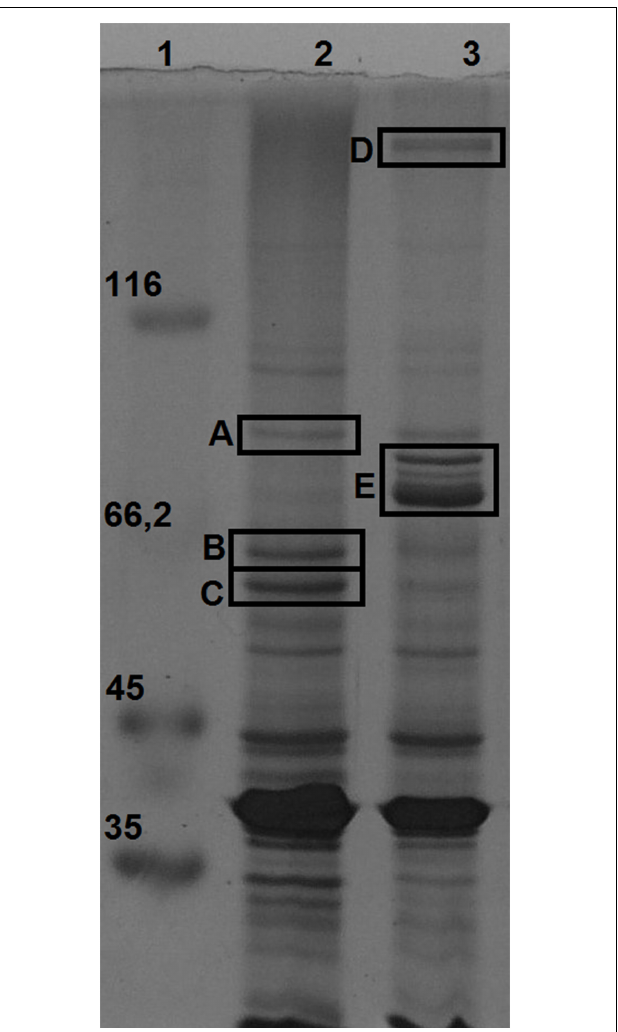
FIGURE 3 | Membrane proteins regulated by iron availability at late exponential growth phase. SDS-PAGE 12% acrylamide gel of total membrane protein enriched fractions of bacteria grown in NFbHP-malate media with different iron conditions: 37 µ M FeCl 3 (lane 2); 50 µ M 2 (cid:48) 2-dipyridyl (lane 3). Molecular weight marker in KDa (lane 1). Letters from (A–E) are bands differentially expressed, identified by MALDI-TOF as: Hsero_4295 (A) ; Hsero_2973, sdhA (B) ; Hsero_0972 (C) ; Hsero_2343, sbtI (D) ; Hsero_3255 ( fiu ), Hsero_2345 ( sbtR ) and Hsero_1277 ( fecA ) (E)